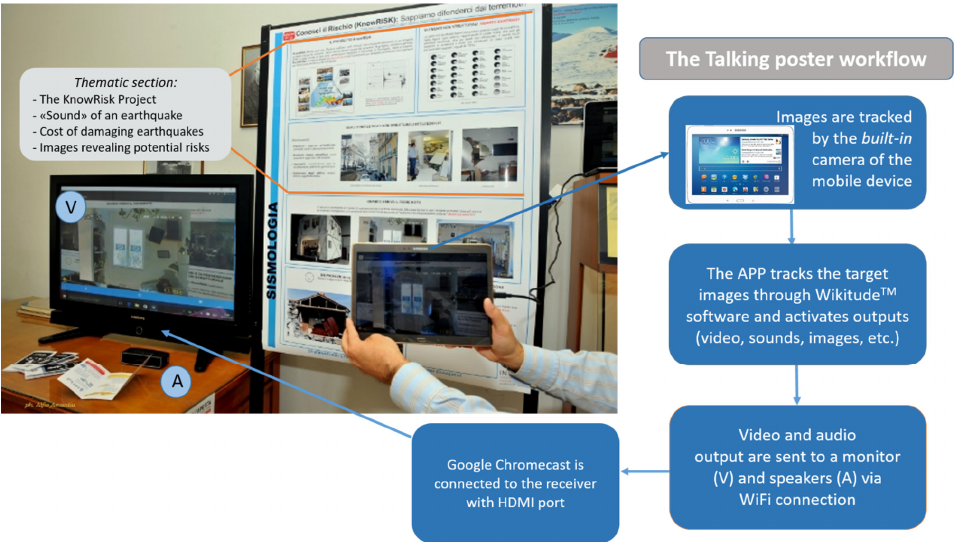
Figure 5. The talking poster workflow. An example of the content of a thematic section is shown on the left-hand side of the figure. The targets with the static content of the talking poster were set up to form thematic sections (Figure 5). Based on modularity, the number of sections was changed; further, the overall content of each one was calibrated according to the audience (youths, laypersons,